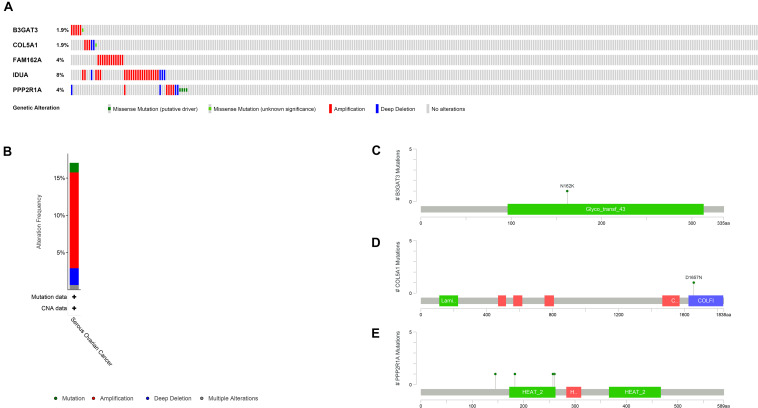
Identification of a prognostic risk signature associated with glycometabolism. (A) Selected gene alterations in 311 clinical samples. (B) Specific alteration frequencies of the selected gene sequences of the clinical samples. (C) Mutations in B3GAT3. (D) Mutations in COL5A1. (E) Mutations in PPP2R1A.